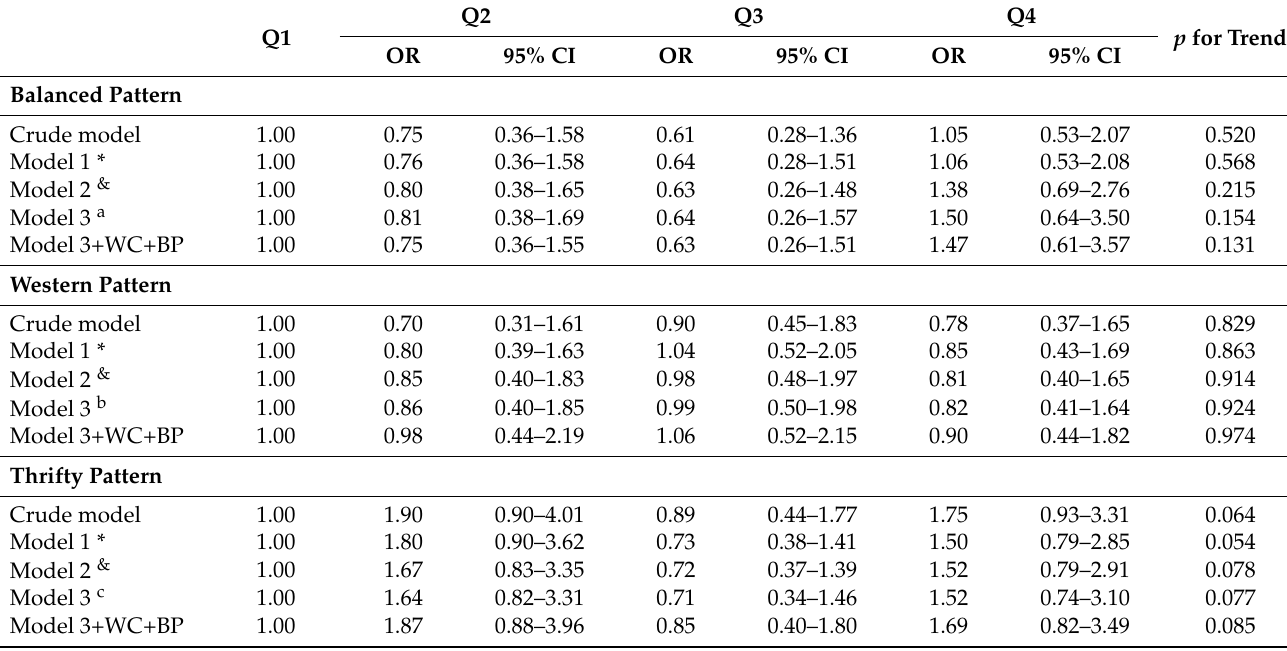
Table 7. Association between low HDL-C and quartiles of dietary patterns in the older participants by BMI subgroups (24.8 <= BMI < 27.1 kg/m 2 ).